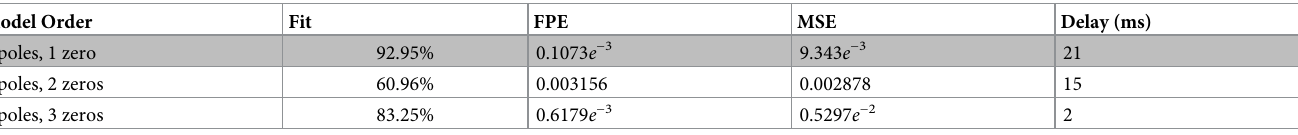
Table 3. Model structure and performance for an example insect (best fit highlighted). Model